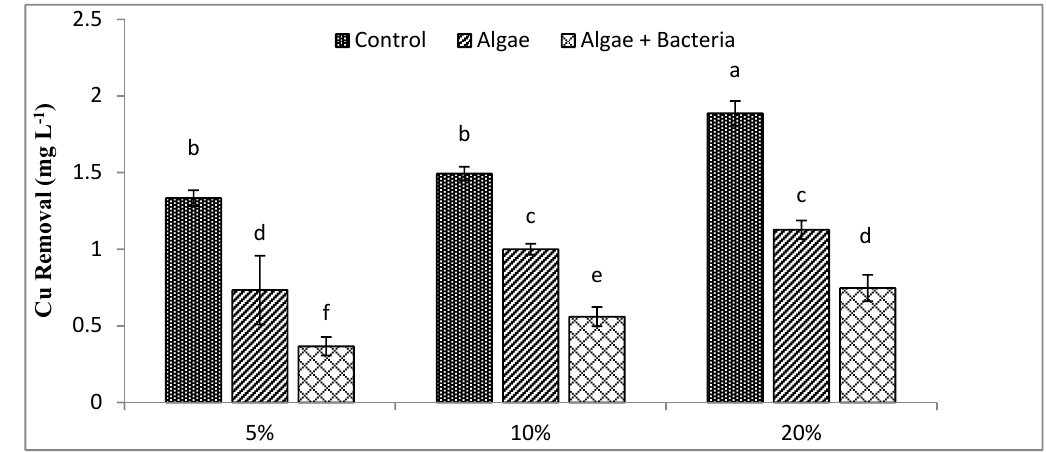
Figure 5. Efficiency of algae and algal–bacterial consortium for copper removal from textile industry wastewater at different dilution levels. Columns show mean values, and bars show standard deviation (SD) of means. All means followed by different letters were significantly different according to Tukey HSD test at p < 0.05.